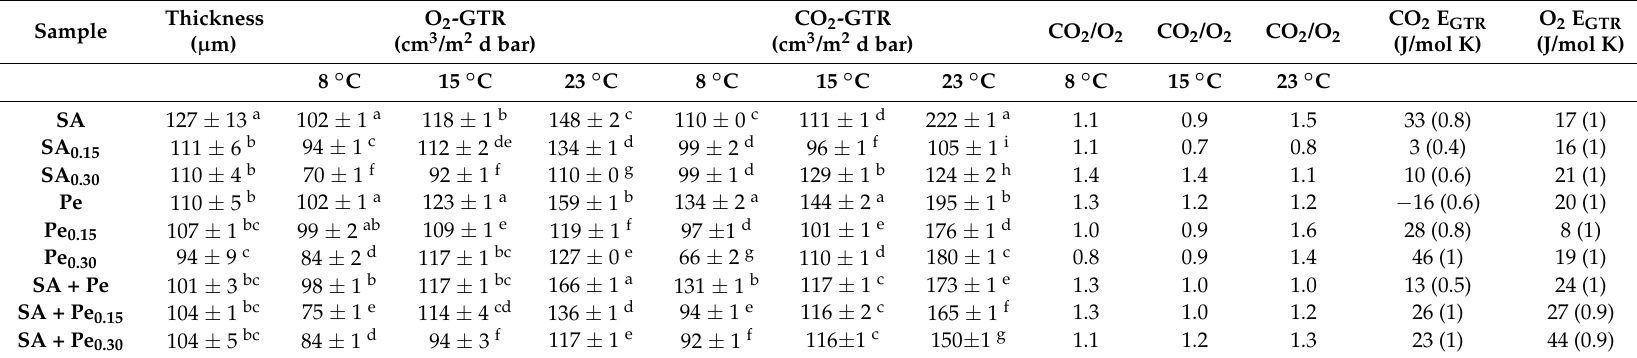
Table 2. Film thickness, O 2 and CO 2 gas transmission rate (GTR) at 8, 15 and 23 ◦ C, with the corresponding perm-selectivity ratio and GTR Activation